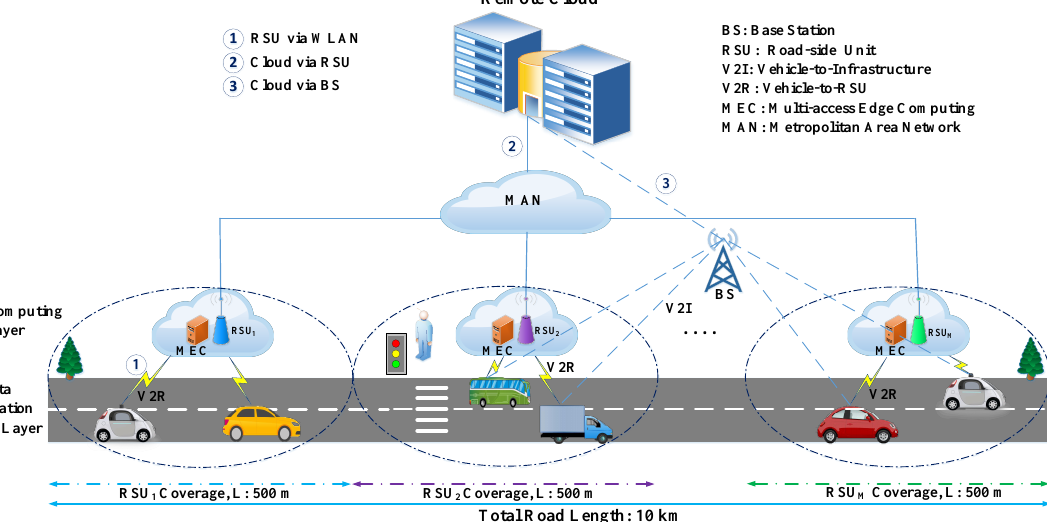
Figure 2. The proposed MEC-enabled vehicular